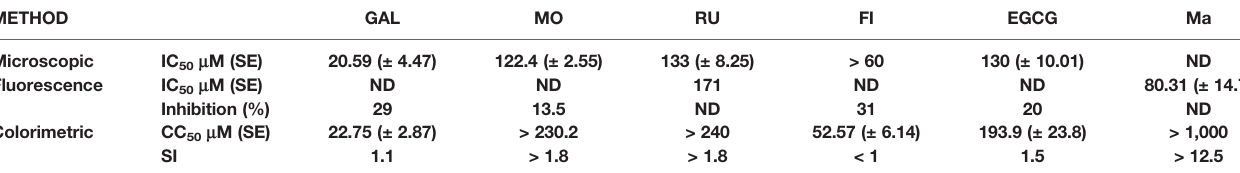
TABLE 1 | In vitro anti-leishmanial activity and cytotoxicity of fl avonoids and the reference drug, MA. METHOD